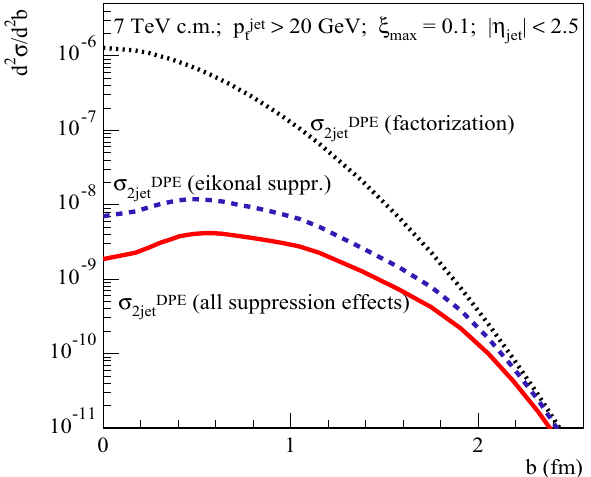
Fig. 15 Transverse profiles for central diffractive dijet production at √ > 20GeV/c,calculatedtakingdifferentabsorptive s = 7TeVfor p jet t − SD ( fact ) / d 2 b (dotted), d 2 σ 2jet − SD ( eik ) / d 2 b effects into account: d 2 σ 2jet pp pp − SD / d 2 b (solid); ξ = 0 . 1, | η | < 2 . 5 (dashed), and d 2 σ 2jet max jet pp − DPE ( fact ) / d 2 b , the corresponding transverse profiles d 2 σ 2jet pp − DPE ( eik ) / d 2 b , and d 2 σ 2jet − DPE d 2 σ 2jet pp